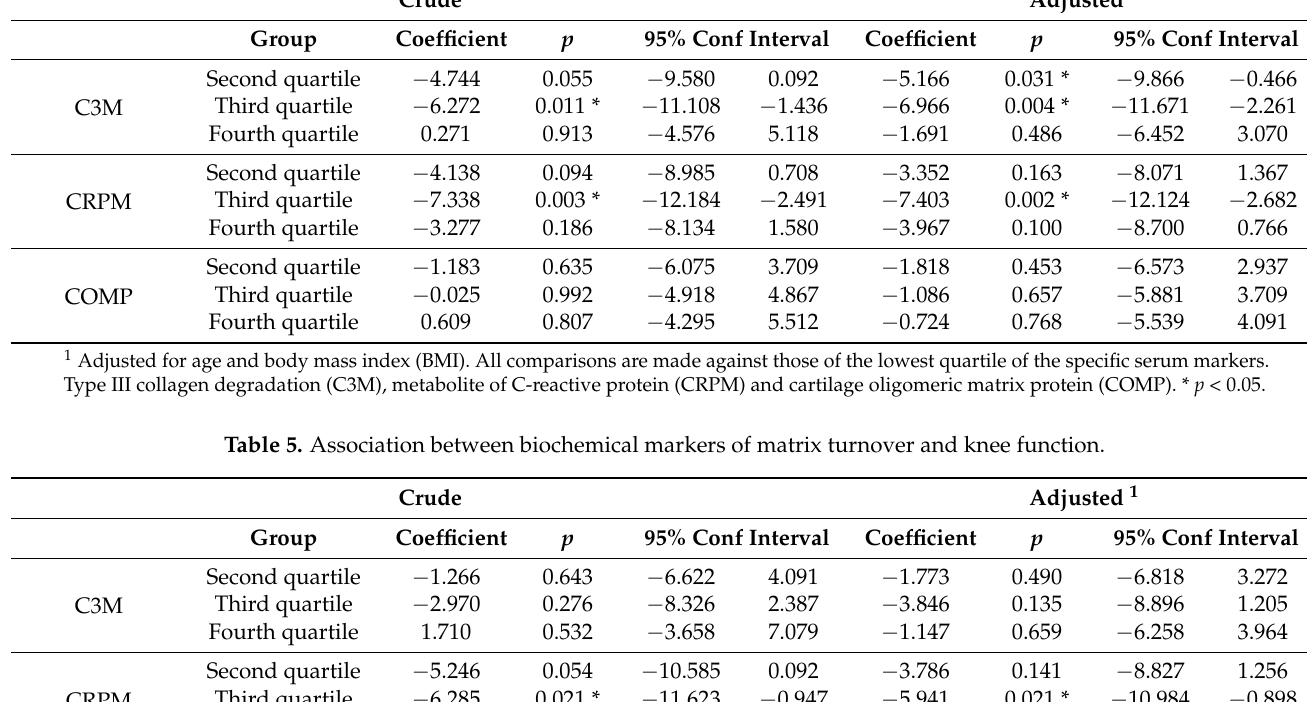
Table 4. Association between biochemical markers of matrix turnover and knee pain. Crude